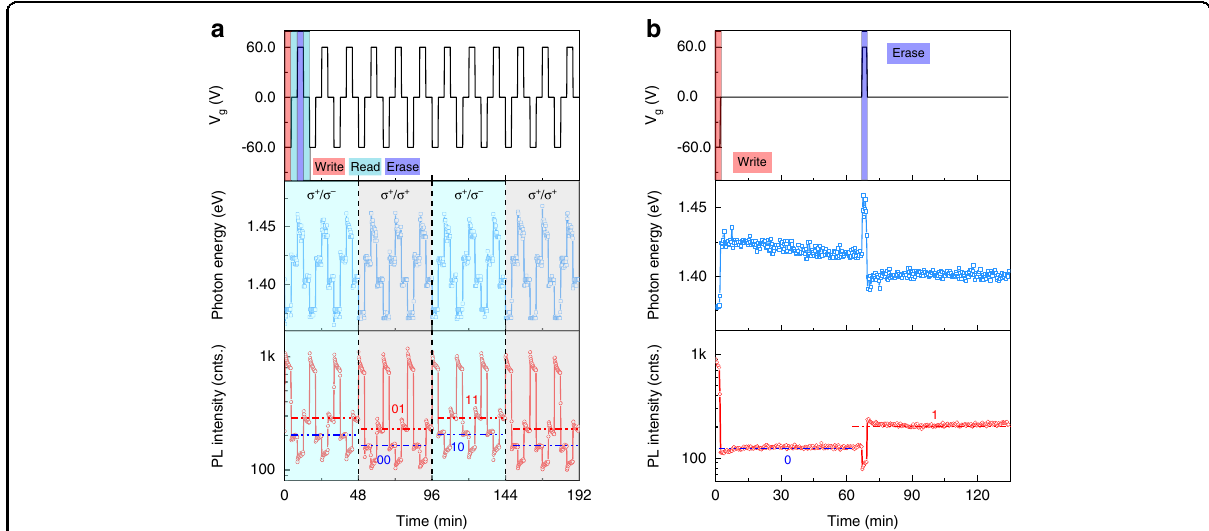
Fig. 5 Electrically controlled memory operations in the HS. a Time-dependent IX emission characteristics upon cyclic V g among − 60, 0, 60, and 0 V. Each voltage lasts for about 4 min. The detecting polarization shifts every three cycles of V g . b Retention time of the “ 1 ” and “ 0 ” excitonic states. The writing and erasing voltages last for about 3 min, and the reading voltage lasts for about 64 min. The peak energies and intensities are extracted from real-time spectra, each of which was measured within 10 s. The sample was excited by a 633 nm laser with a power of 180 μ W at 78